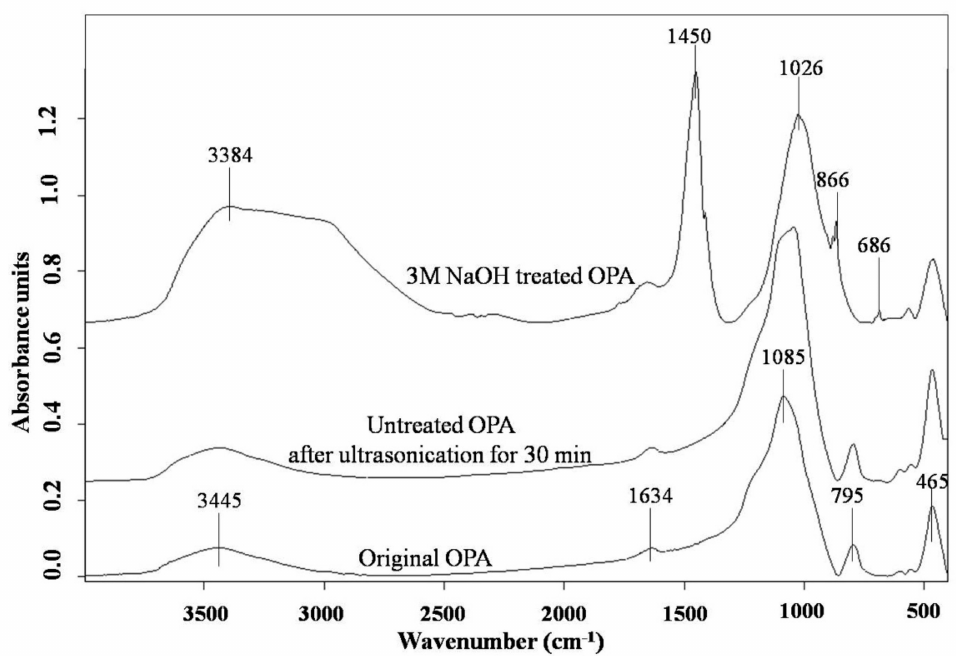
Figure 9. FTIR spectra of original OPA, untreated OPA after ultrasonication for 30 min and 3M NaOH-treated OPA followed by ultrasonication for 30 min. Table 7. Curing characteristics of unfilled NR and OPA and tOPA filled NR compounds with different loading.